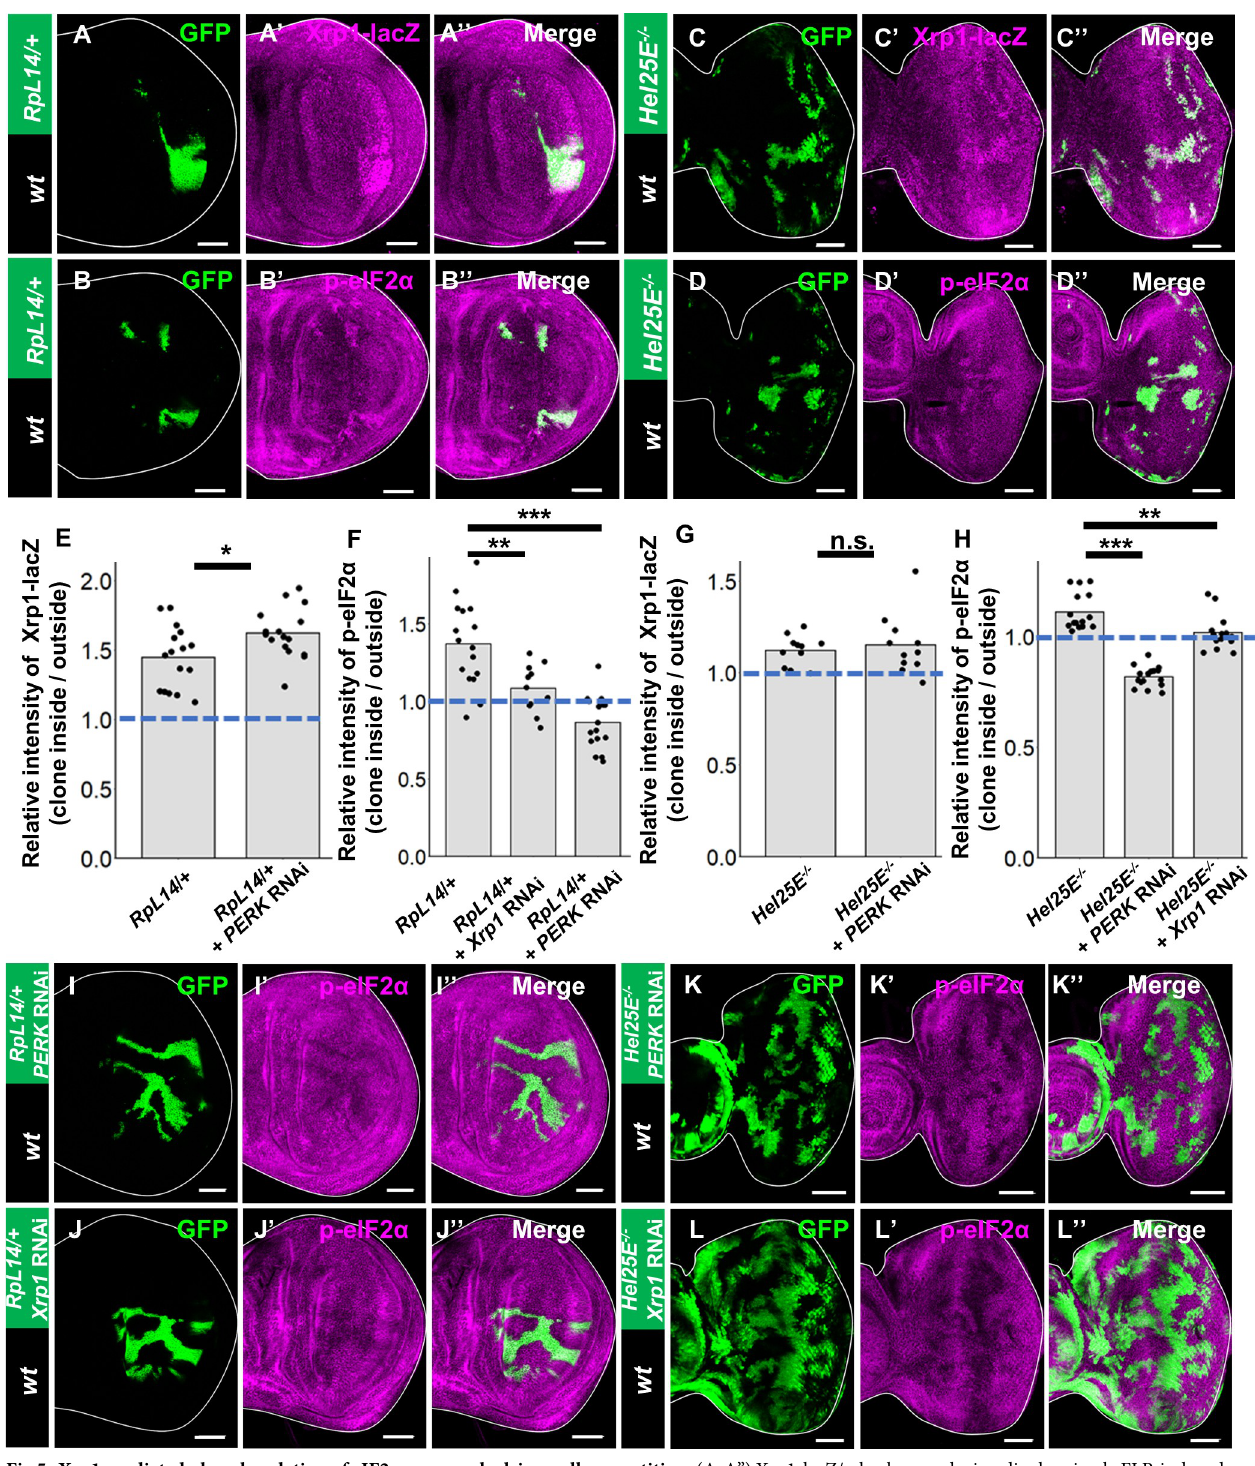
Fig 5. Xrp1-mediated phosphorylation of eIF2 α commonly drives cell competition. (A-A”) Xrp1-lacZ/+ background wing disc bearing hsFLP-induced GFP-labeled clones of RpL14/+, salE > GFP cells stained with anti- β -gal. (B-B”) Wild-type background wing disc bearing hsFLP-induced GFP-labeled clones of RpL14/+, salE > GFP cells stained with anti-phosphorylated eIF2 α . (C-C”) Xrp1-lacZ/+ background eye disc bearing eyFLP-induced MARCM clones of Hel25E-/- cells stained with anti- β -gal. (D-D”) Wild-type background eye disc bearing eyFLP-induced MARCM clones of Hel25E-/- cells stained with anti- phosphorylated eIF2 α . (E) Quantification of the intensity of anti- β -gal staining in clones shown in A and S5.A. Error bars, SD; ��� p < 0.001 by Welch’s t-test.